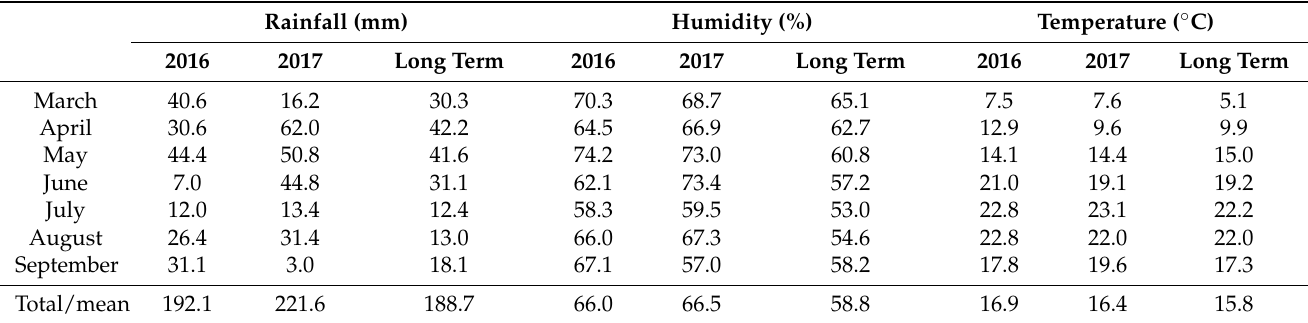
Table 9. The average rainfall (mm), temperature ( ◦ C), and humidity (%) during the experimental period at Eskisehir in 2016, 2017, and the long